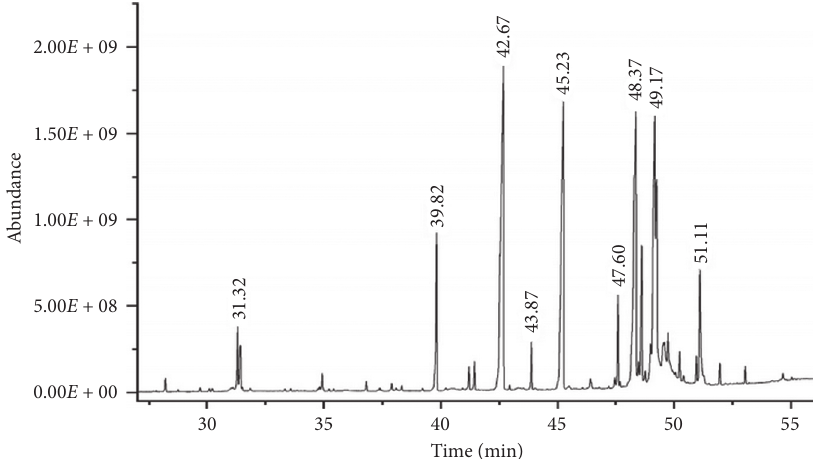
Figure 4: The GC-MS chromatrogram of stingless bee